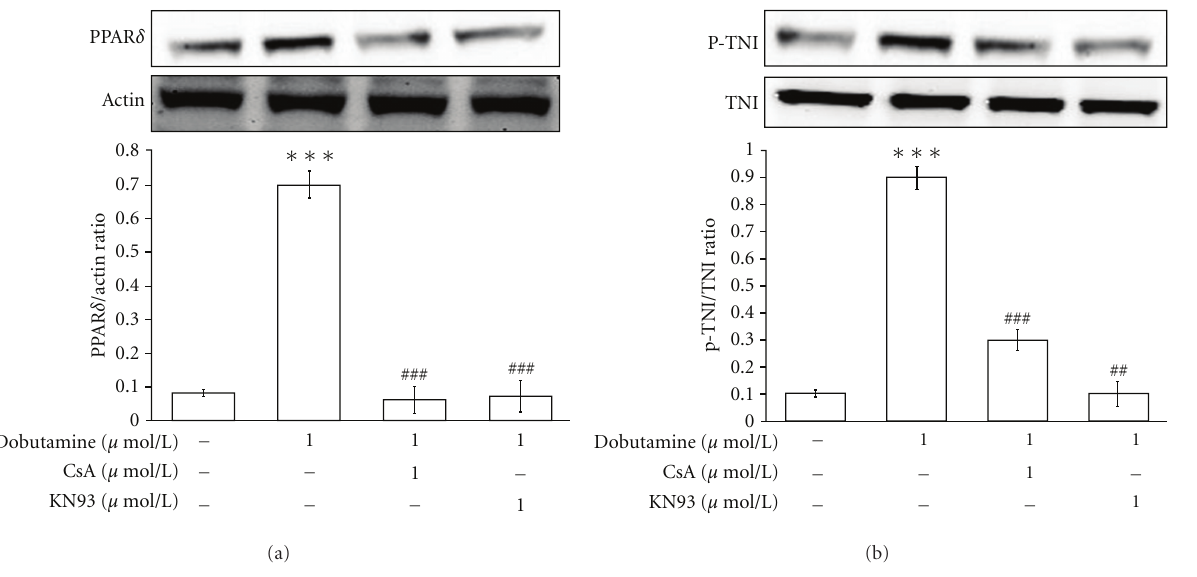
Figure 3: E ff ects of calcium-mediated signaling inhibitors on dobutamine-induced actions in neonatal rat cardiomyocytes . The neonatal rat cardiomyocytes were treated with 1 μ mol/L cyclosporine A (CsA, calcineurin inhibitor) or 1 μ mol/L KN93 (CaMK inhibitor) at 30 minutes prior to incubation with 1 μ mol/L dobutamine for 4 hours. The cells were then harvested to measure PPAR δ protein expression (a) and cTnI phosphorylation (b) using Western blotting analysis. All values are expressed as mean ± SEM ( n = 6 per group). ∗∗ P < 0 . 01 as compared with control cells. ## P < 0 . 01 as compared to the control cells incubated with dobutamine